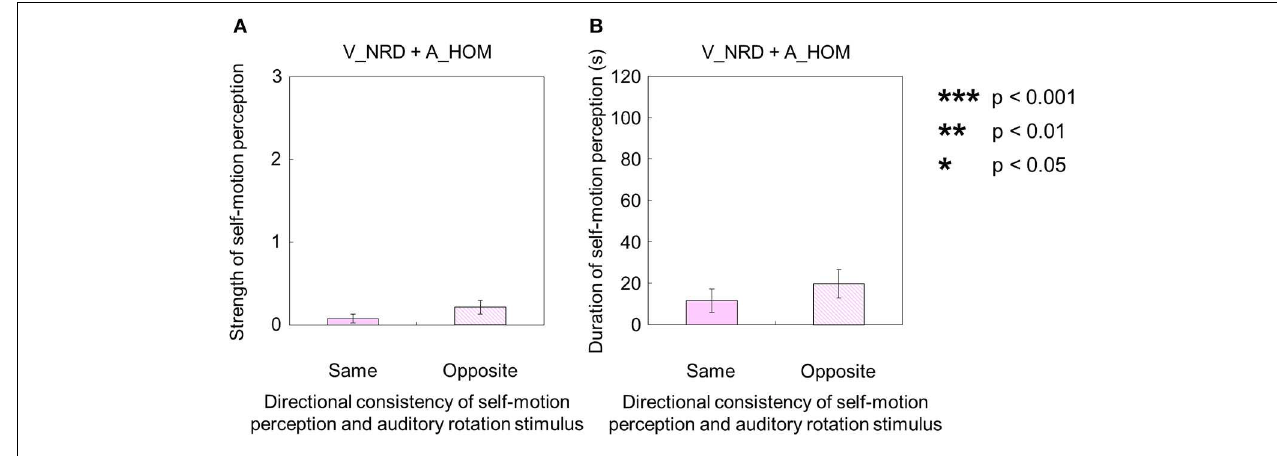
FIGURE 7 | Averaged values of the (A) strength and (B) duration of self-motion perception in the condition combining no visual stimulus (V_NRD) and auditory horizontal one-directional motion